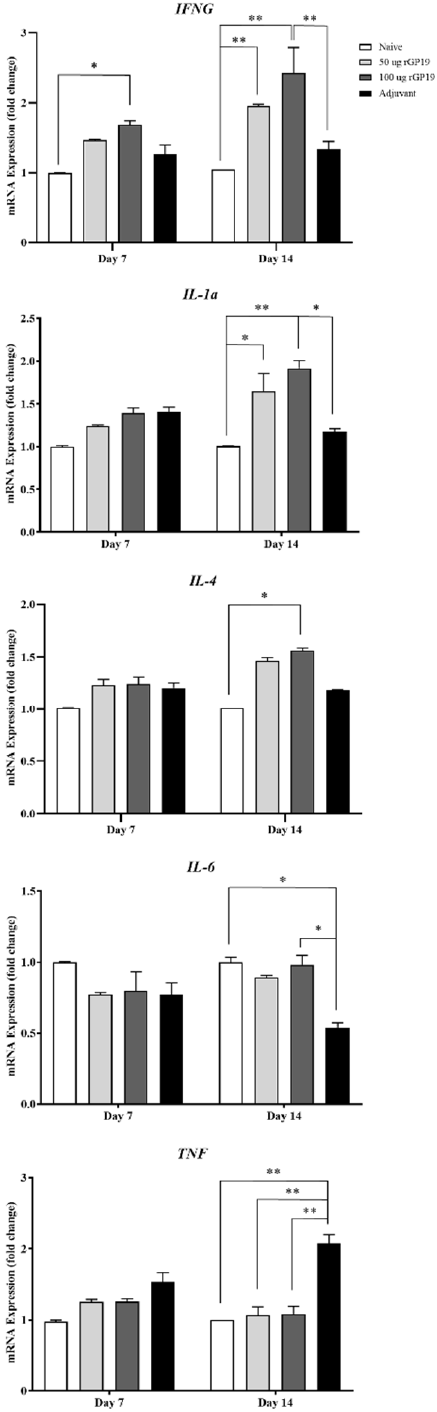
Figure 4. Analyses of cytokine mRNA expression in mice using qPCR. Bar graphs represent relative IFNG , IL-1a , IL-4 , IL-6 , and TNF mRNA expression levels after normalization to the GAPDH gene in naive and immunized mice with later Ehrlichia canis challenge group (50 µ g rGP19, 100 µ g rGP19, and adjuvant). Data are represented as mean ± SE ( n = 5 each treatment), one-way ANOVA, * p < 0.05, ** p <